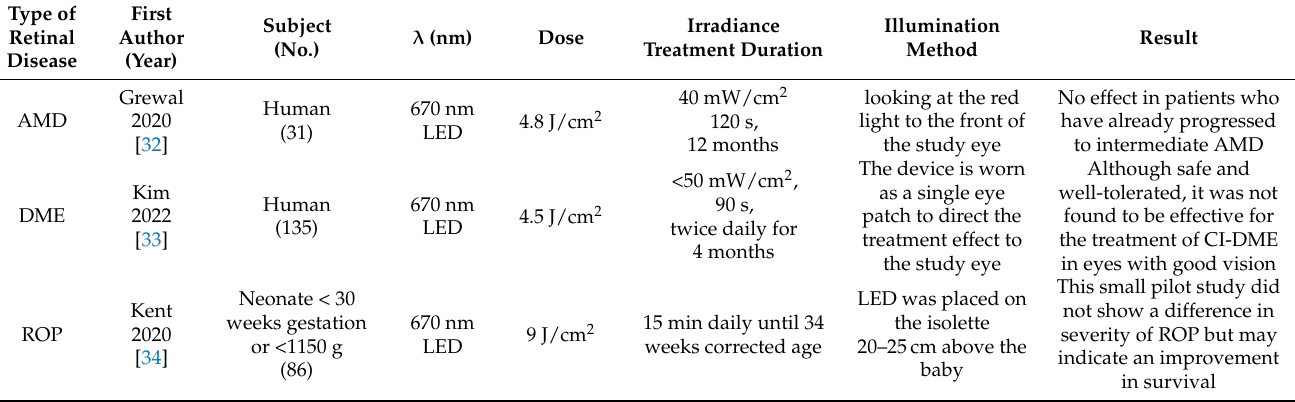
Table 3. Clinical studies on PBM for the treatment of retinal diseases (negative